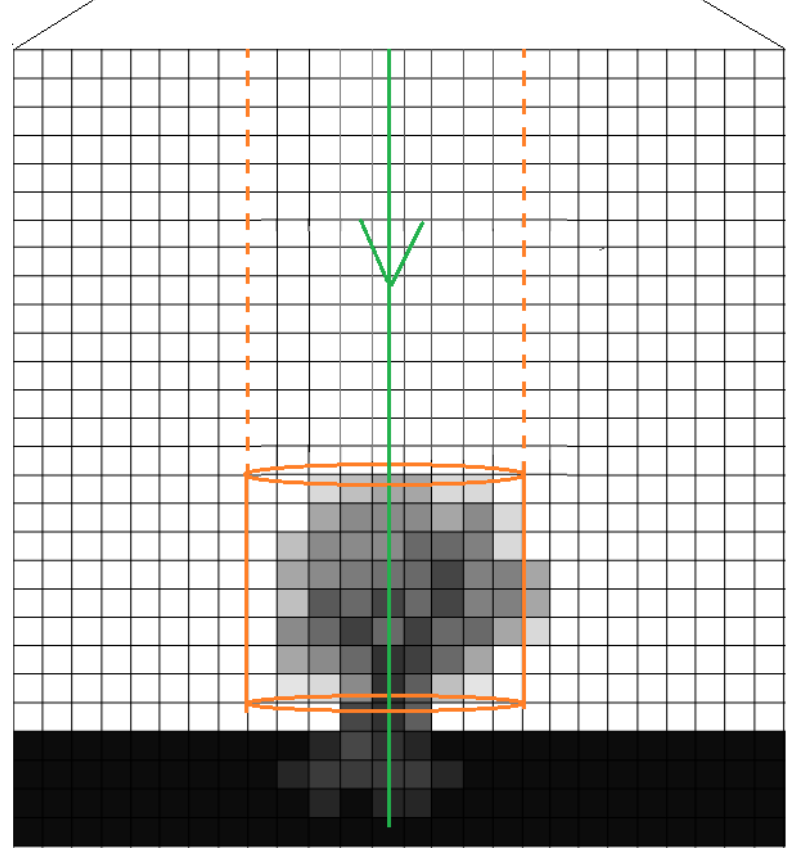
Figure 8. Features from local areas are extracted using 3D cylindrical windows. For each column of interest, a window is placed such that the column of interest lies in the middle of the 3D-window. Starting from the top of the voxelised space the 3D-window is moved downwards until the first non-empty column of the middle column is reached. Information are extracted from the area that lies inside the 3D-window (middle column and its